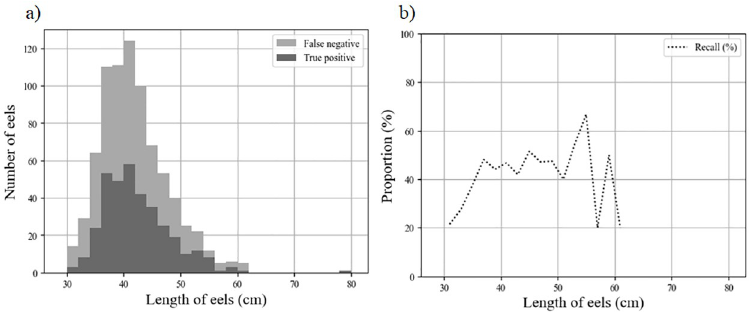
Fig 7. Performance metrics (cumulative false negative and true positive distributions and recall values) of the method as a function of the measured length of eels (cm) for the PLN-ARIS